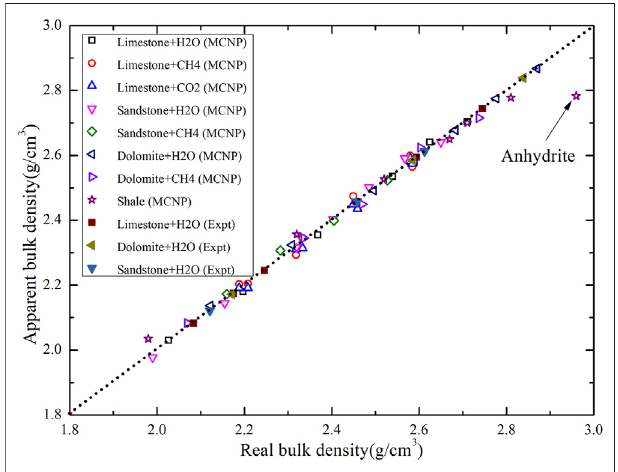
FIGURE 10 | Diagram of the results for various formations from the MCNP tool model and experimental tool processed using the Levenberg – Marquardt